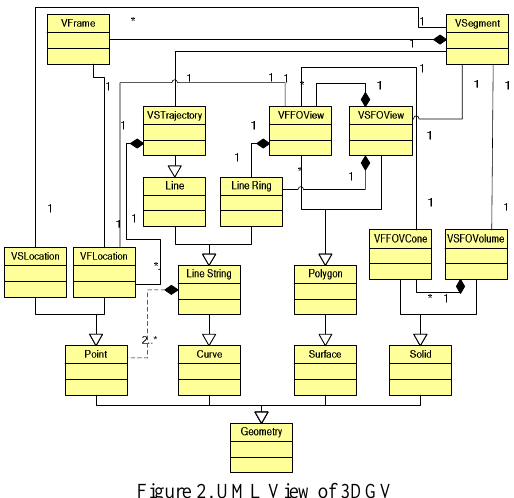
Figure 2. UML View of 3DGV